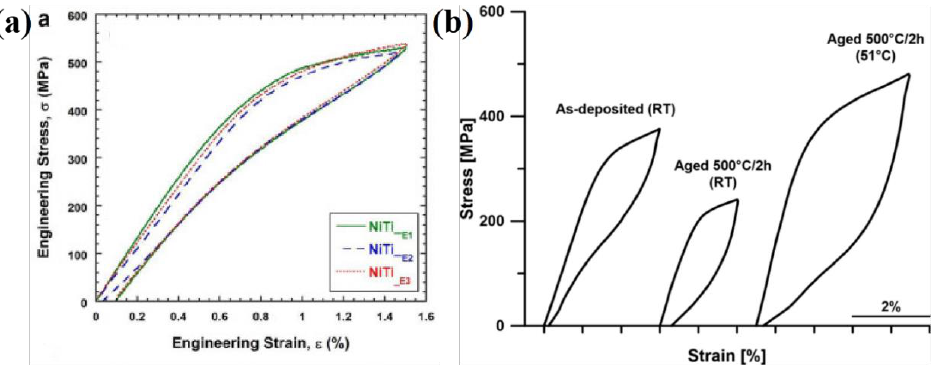
Figure 12. Ni-Ti alloy formed by LENS ( a ) superelastic response under different laser energy densities; ( b ) superelastic effect after aging treatment [35,36].